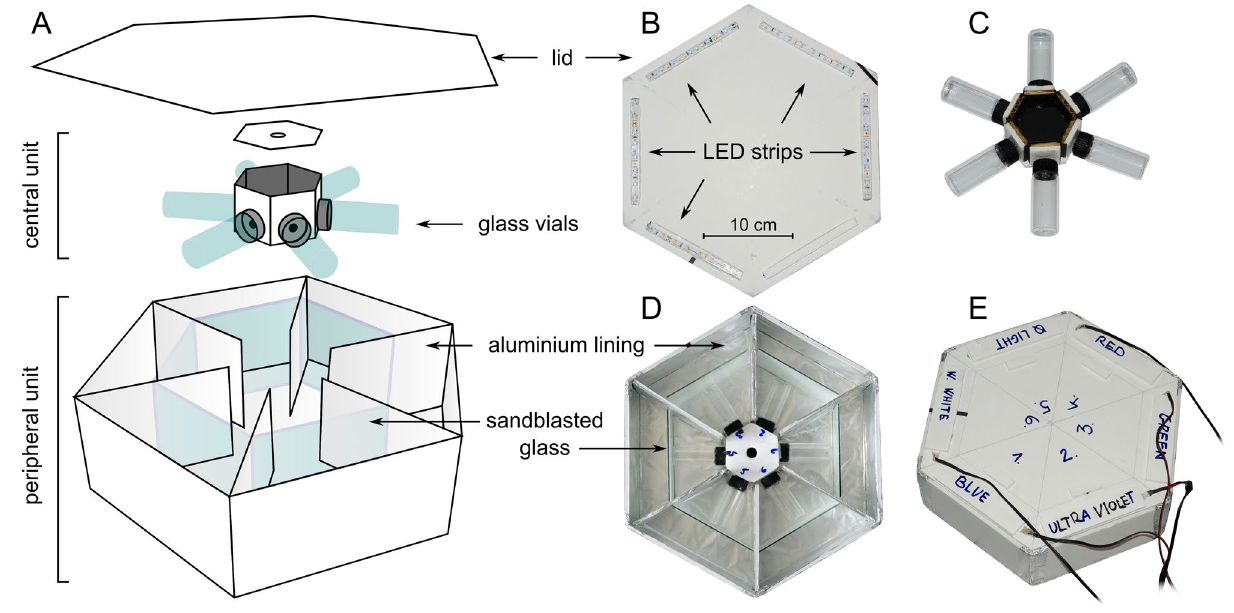
Figure 2. Experimental setup of behavioural experiment 2. ( A ) Exploded view of the hexagonal choice-box. ( B ) Bottom of the lid of the choice-box with the exchangeable LED strips. ( C ) Central unit with the glass vials. ( D ) Peripheral unit with the central unit inside. ( E ) Photo of the choice box with the closed